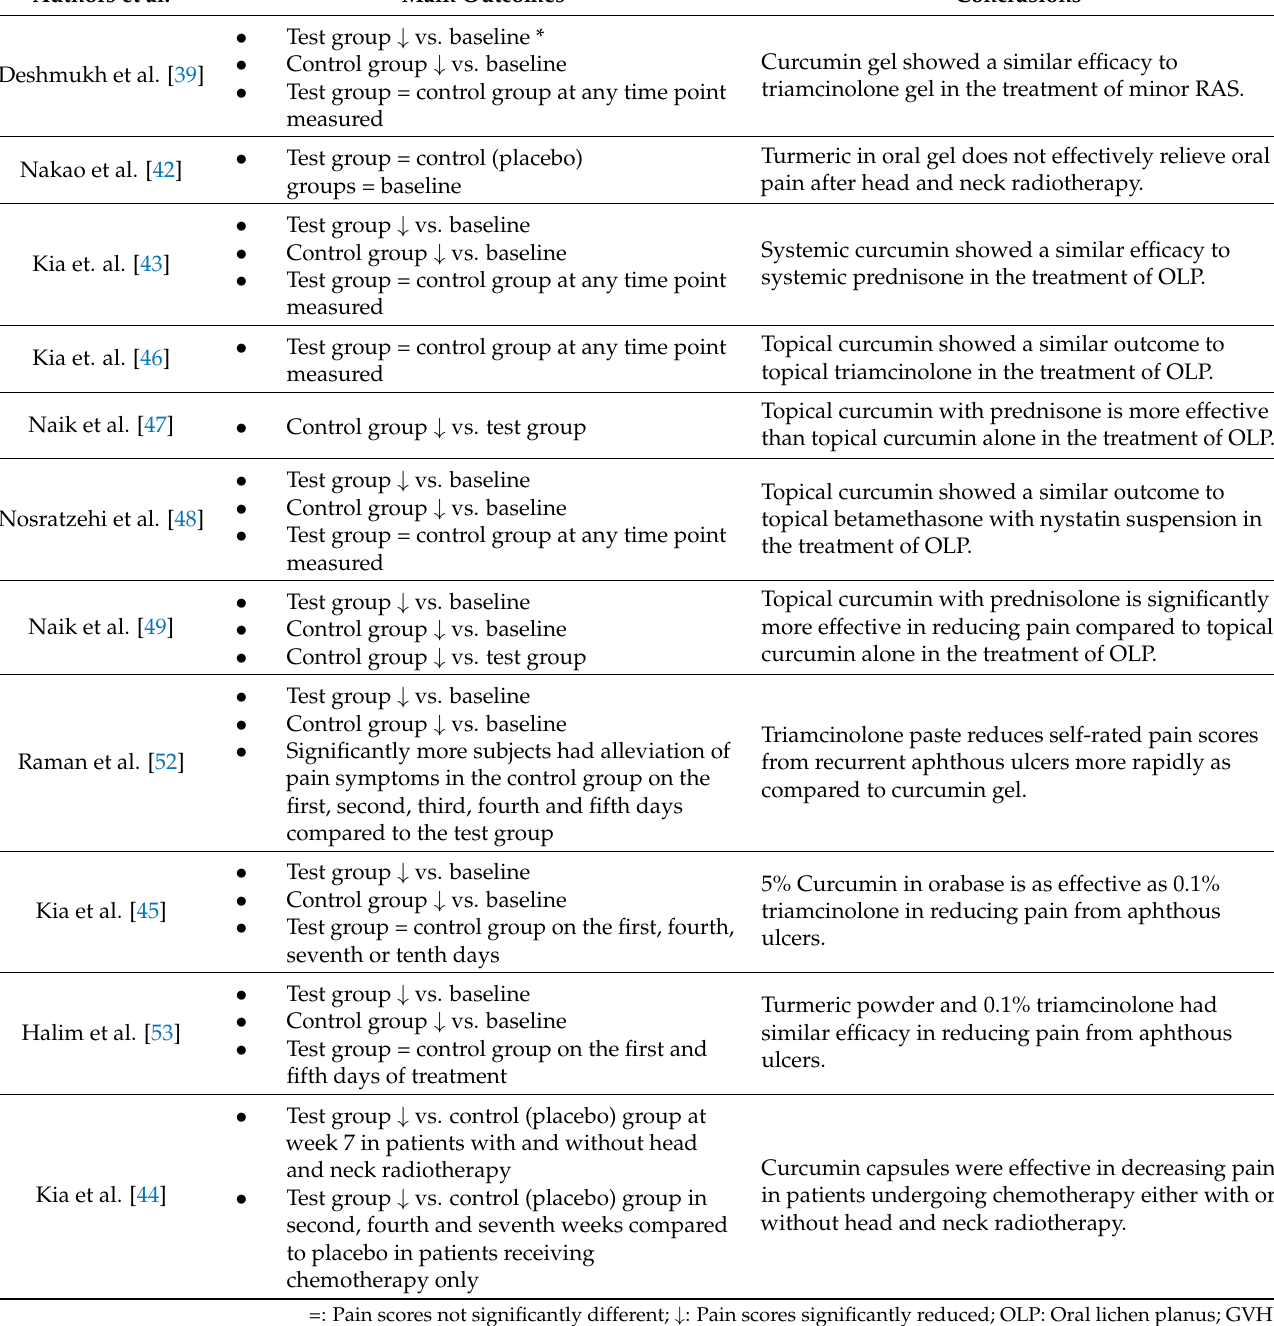
Table 4. Main outcomes and conclusions of studies with curcumin-only-treated study